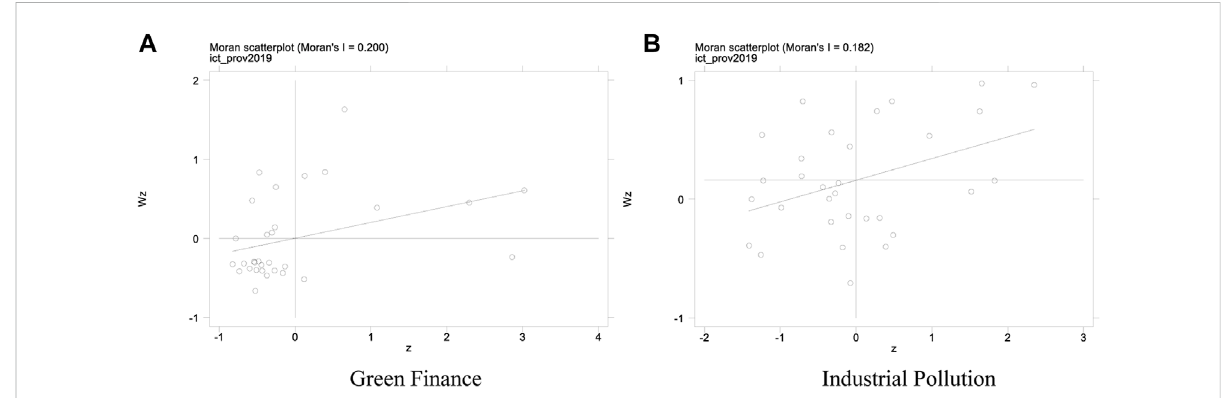
FIGURE 2 Local map of green fi nance and industrial pollution in 2019 (A) Green Finance (B) Industrial Pollution.